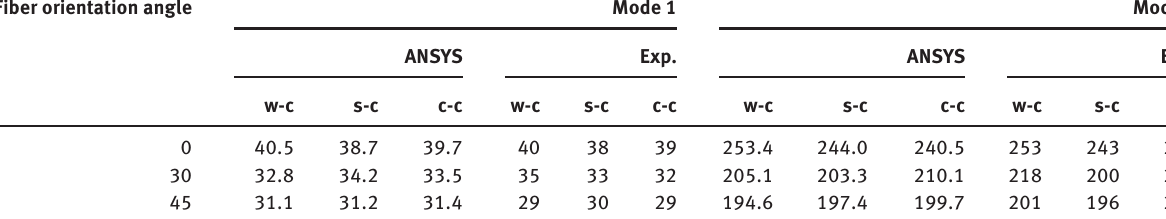
Table 3 Natural frequencies of laminated composite plate.